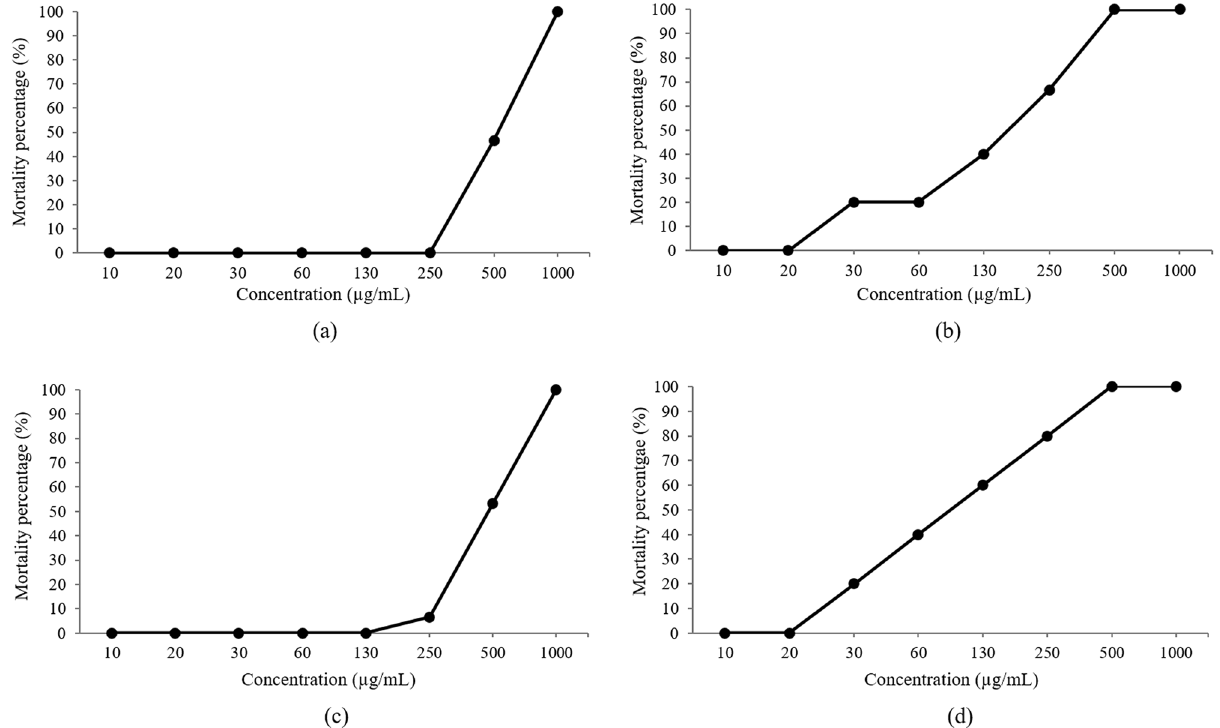
Figure 6. Average embryo mortality percentage against concentration of extract and standard reference solution after 96 h of observation: ( a ) P. niruri extract ( b ) gallic acid, ( c ) corilagin, ( d ) ellagic